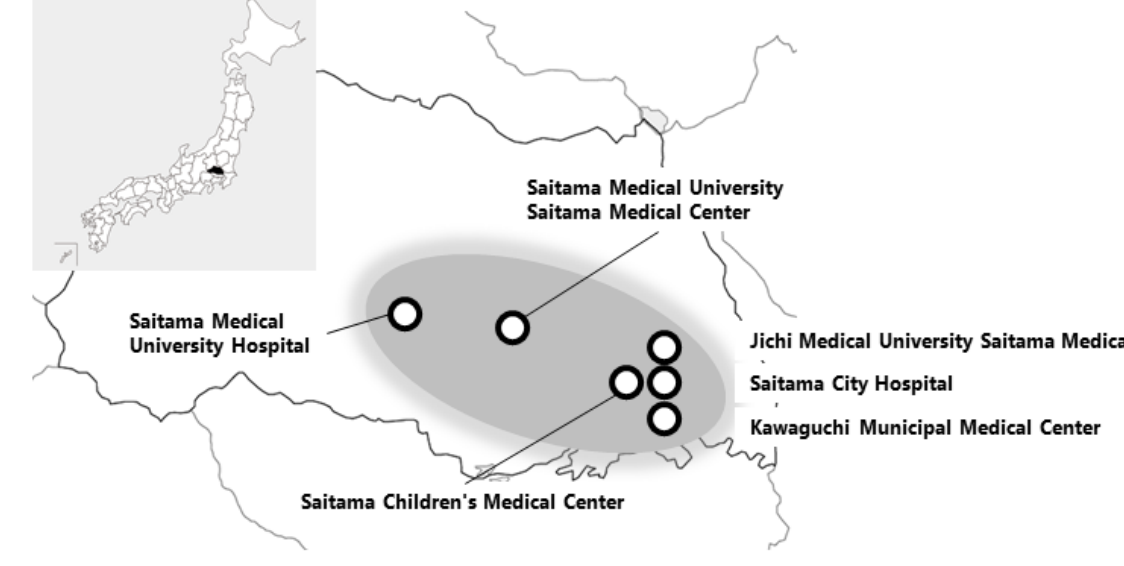
Figure 1. Centers participating in the study. The map has been taken from https://n.freemap.jp/. The copyright belongs to